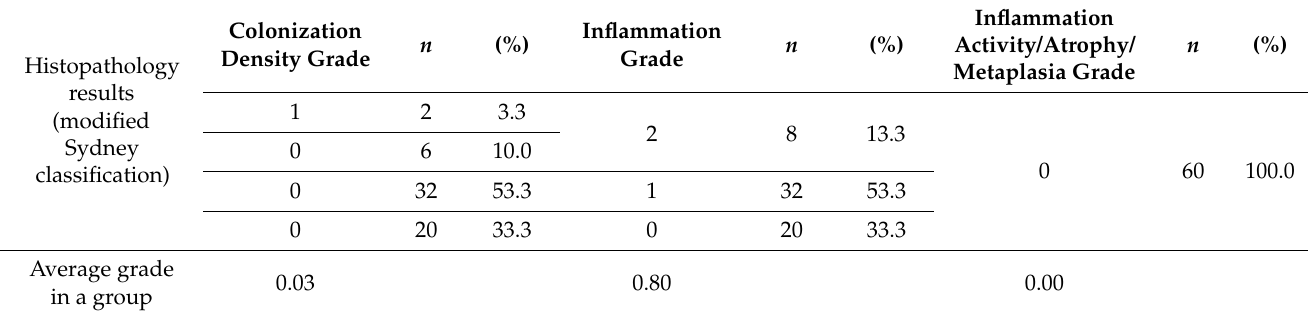
Table 2. Distribution of the histopathological investigation grades (modified Sydney classification) observed in the samples derived from the group of patients with negative PCR results ( n =